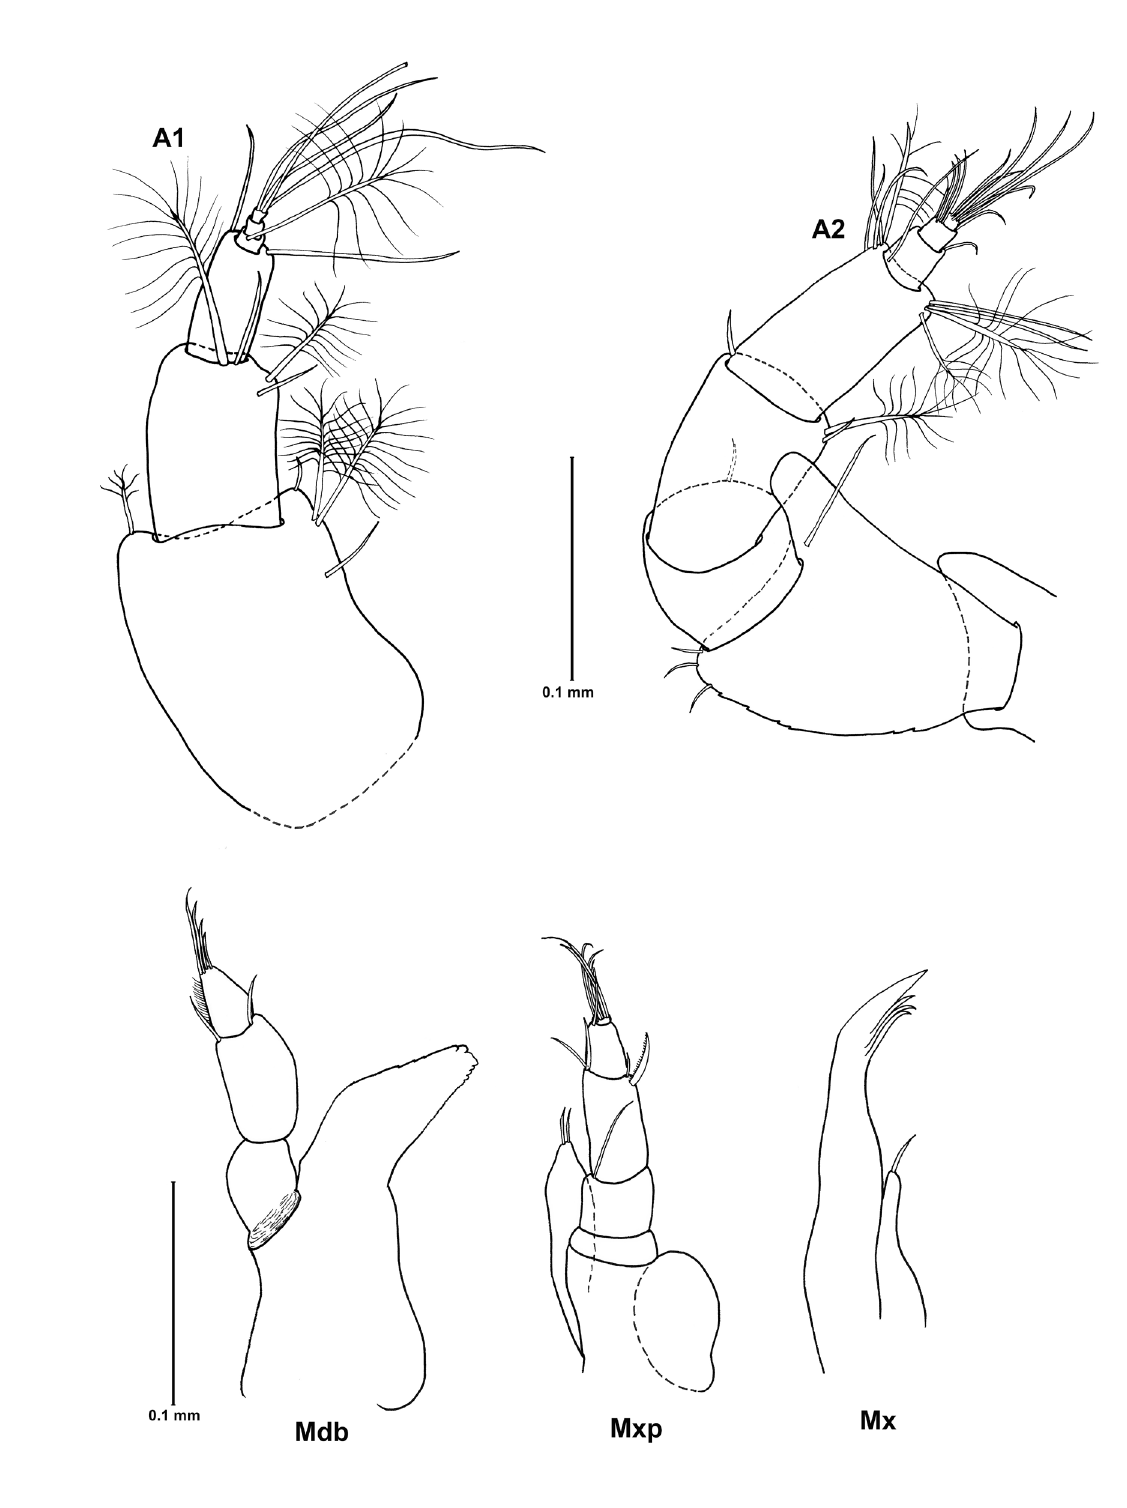
Fig. 24. Expanathura marcoi sp. nov., holotype, ♀ (3.1 mm) (MZB Iso 108). Abbreviations: A1 = antenna 1; A2 = antenna 2; Md = mandible; Mx = maxilla; Mxp =